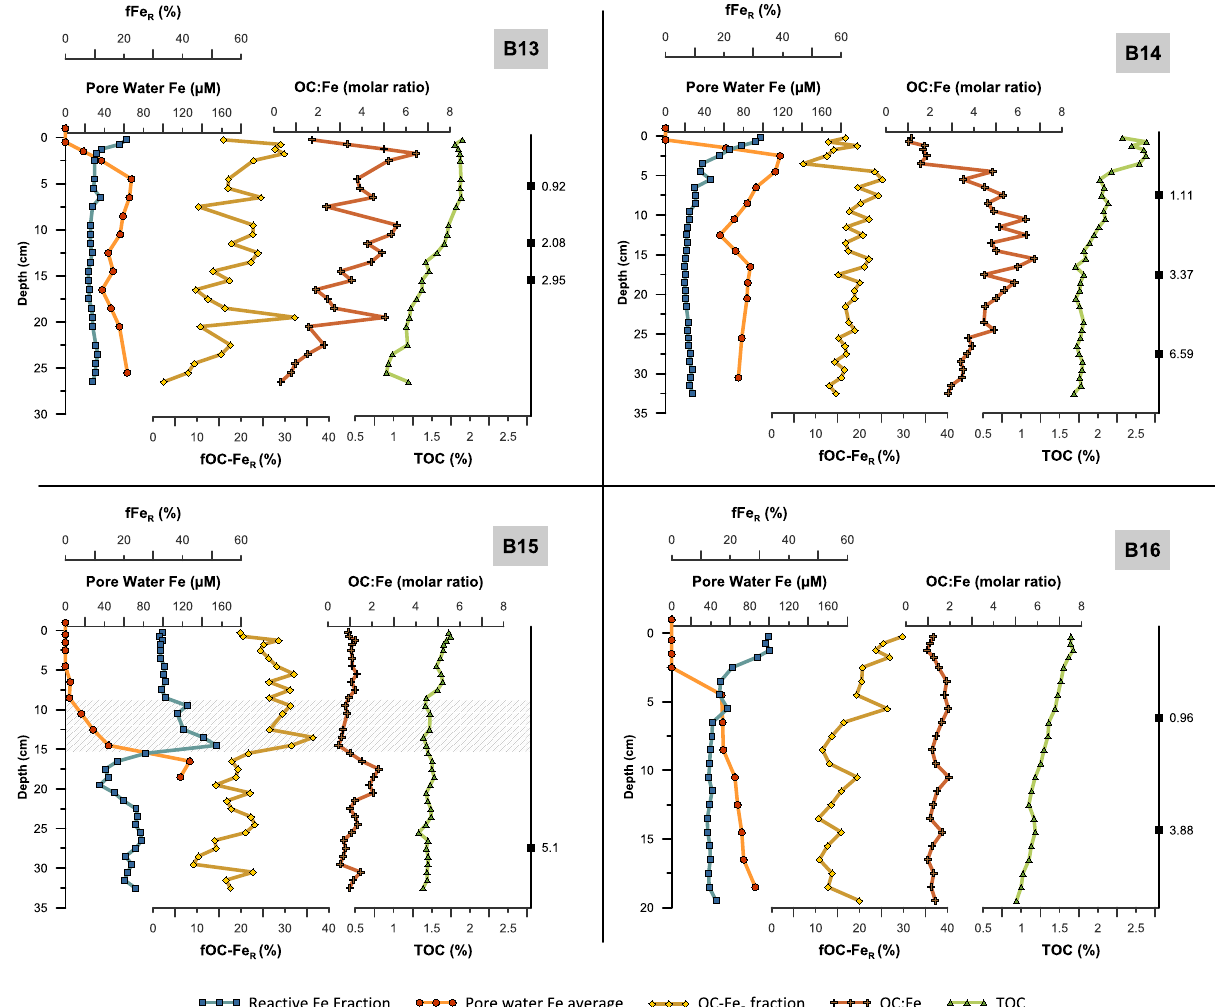
Fig. 2 Downcore measurement of pore water iron content and sedimentary total iron, reactive iron, total organic carbon content, as well as the fraction of total organic carbon bound to reactive iron and the OC to iron molar ratio. The pore water iron content represents the average iron concentration from three different cores at the same coring location. Black squares are uncalibrated radiocarbon dates in kyr BP. The shaded grey area at station B15 marks the location of a reddish/pink sediment layer.